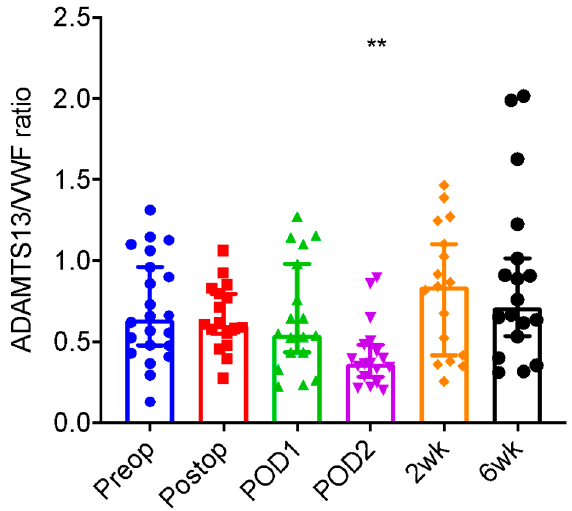
Figure 3. A Disintegrin and Metalloprotease with Thrombospondin type 1 repeats, 13/von Willebrand factor (ADAMTS13/VWF) ratios in patients before and after joint arthroplasty. Plasma ADAMTS13/VWF ratios in patients before (Preop), immediately (postop), one day (POD1), two days (POD2), two weeks (2 wk), and six weeks (6 wk) after elective joint arthroplasty. Each dot represents a result from each patient. The vertical bars are the medians (±95% confidence interval). Here, ** indicates p < 0.01.